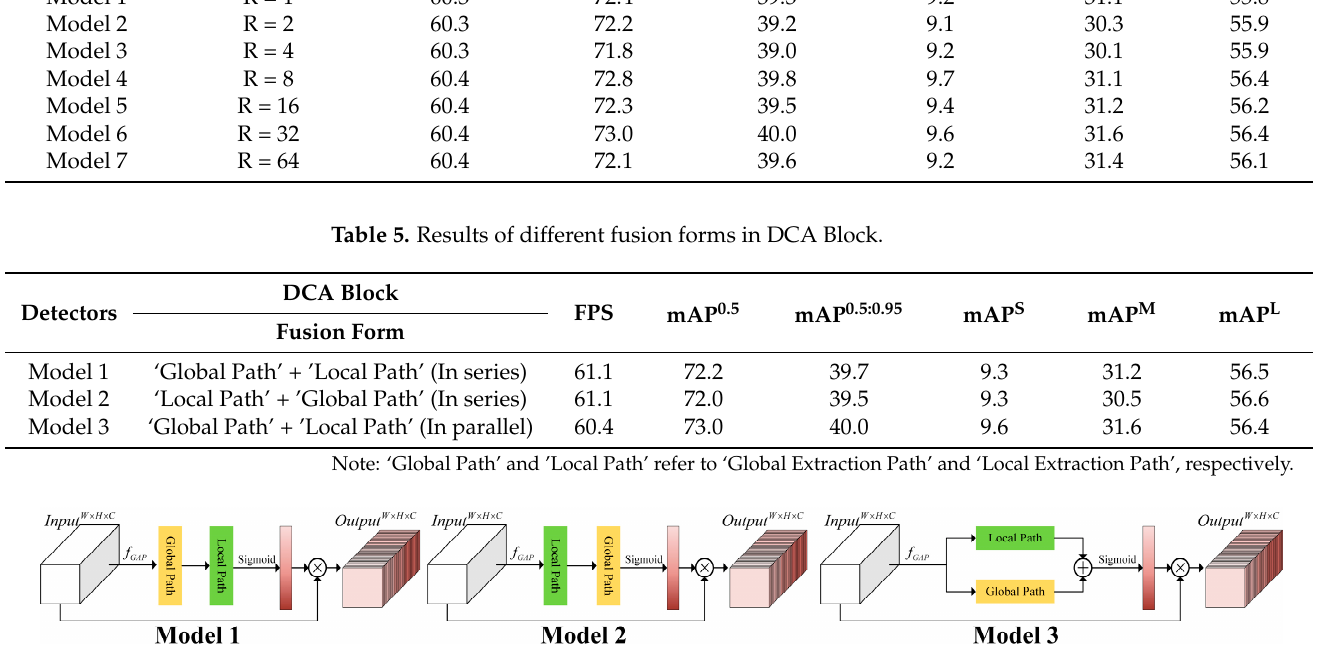
Figure 14. The structure of DCA Block in each detector in Table 5.